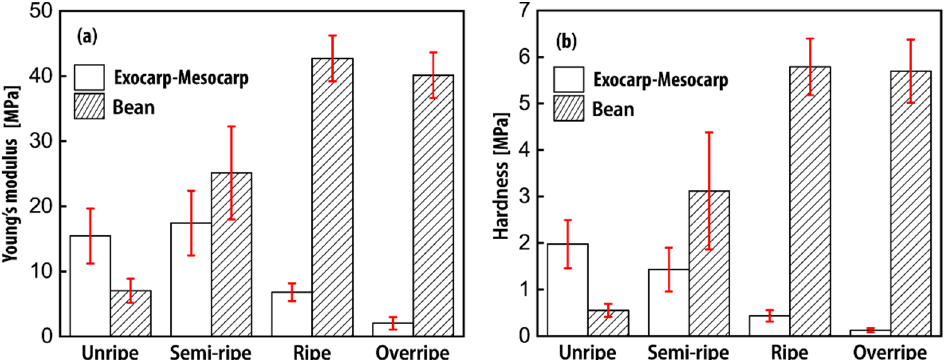
Figure 5. ( a ) Young’s modulus. ( b )